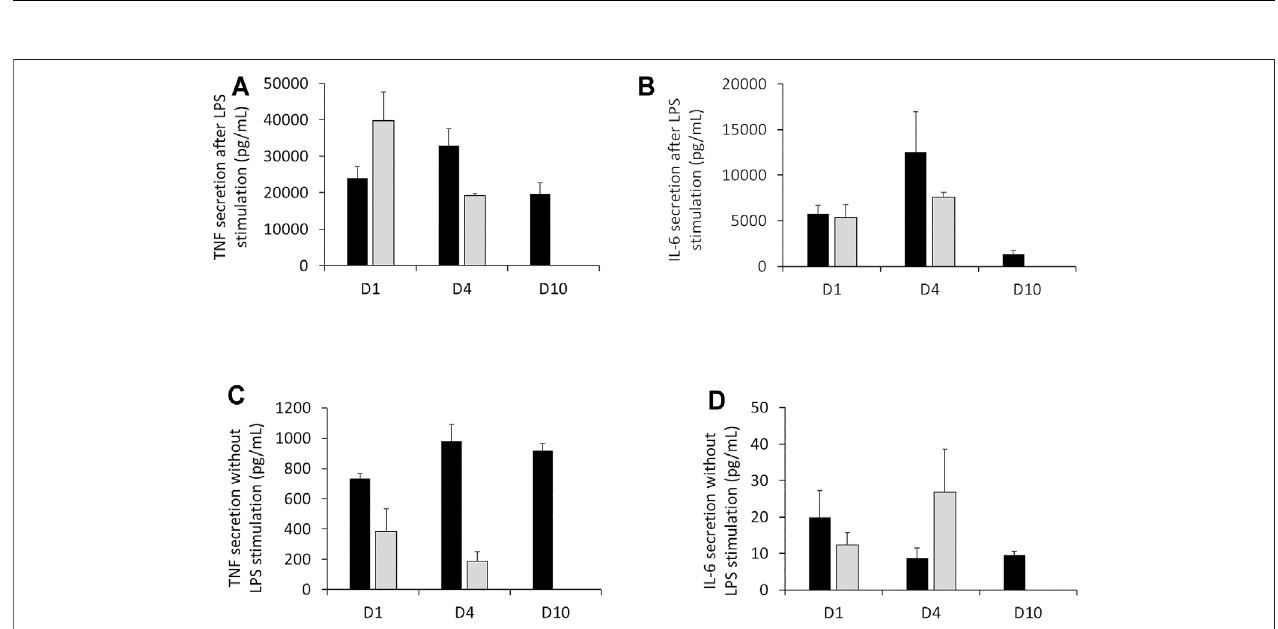
FIGURE5| MeasurementofTNFsecretionandIL-6cytokinesinthepresenceorabsenceofLPSstimulation. (A) AssessmentofTNFreleasedbyJ77A.1cellswith LPS stimulation (pg/ml). (B) Assessment of the IL-6 released by J774A.1 cells with LPS stimulation (pg/ml). (C) Assessment of TNF released by J774A.1 cells without LPSstimulation(pg/ml). (D) AssessmentofIL-6releasedbyJ774A.1cellswithoutLPSstimulation(pg/ml)(N (cid:1) 3).Blackbars;culturemediumsupplementedwithDMEM +1% Horse Serum (1% HS). Grey bars; culture medium supplemented with DMEM +10% Fetal Bovine Serum (FBS). No measurements were made for cells maintained in DMEM+10% FBS at day 10, because of the important cell detachment, as mentioned in the previous section.